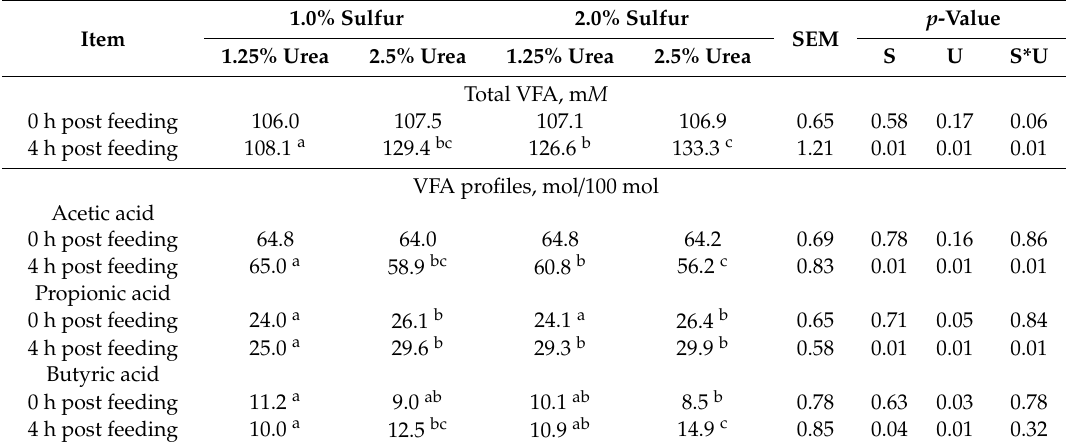
Table 5. Volatile fatty acid (VFA) of rumen fluid of dairy cow fed fermented total mixed